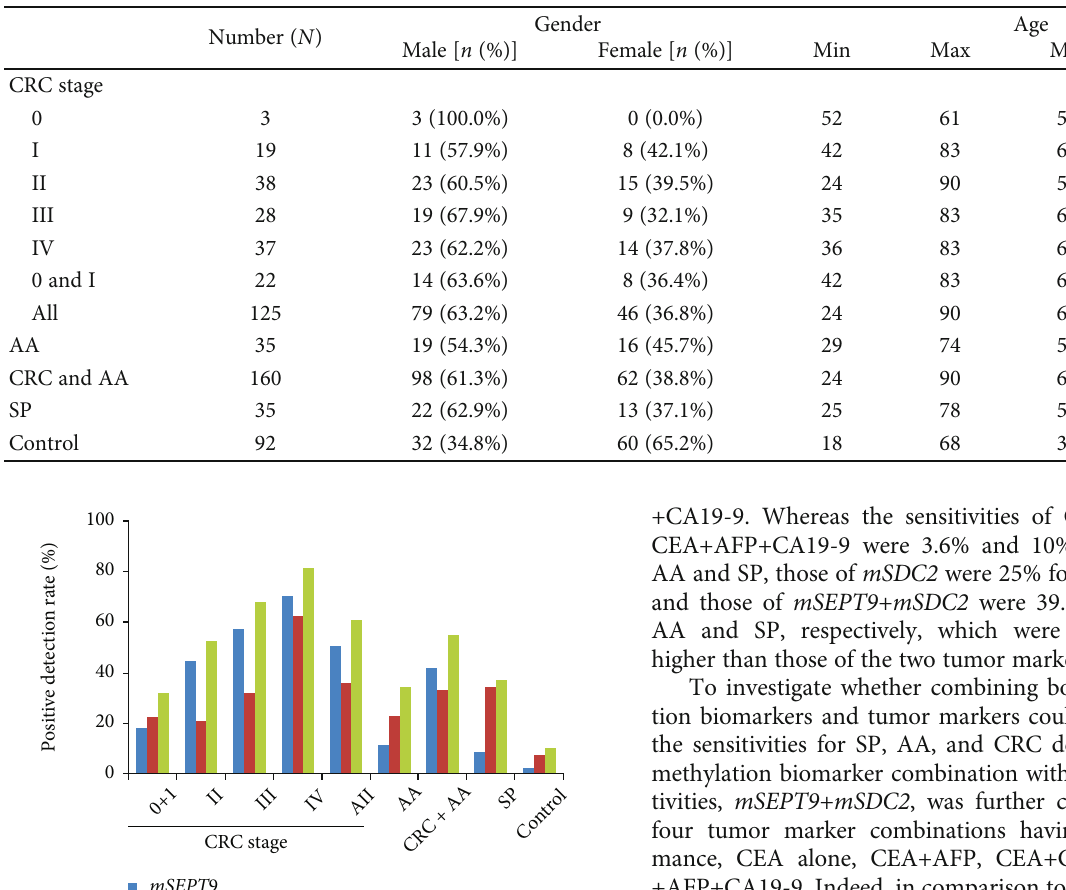
Table 1: Characteristics of subjects enrolled in this study.